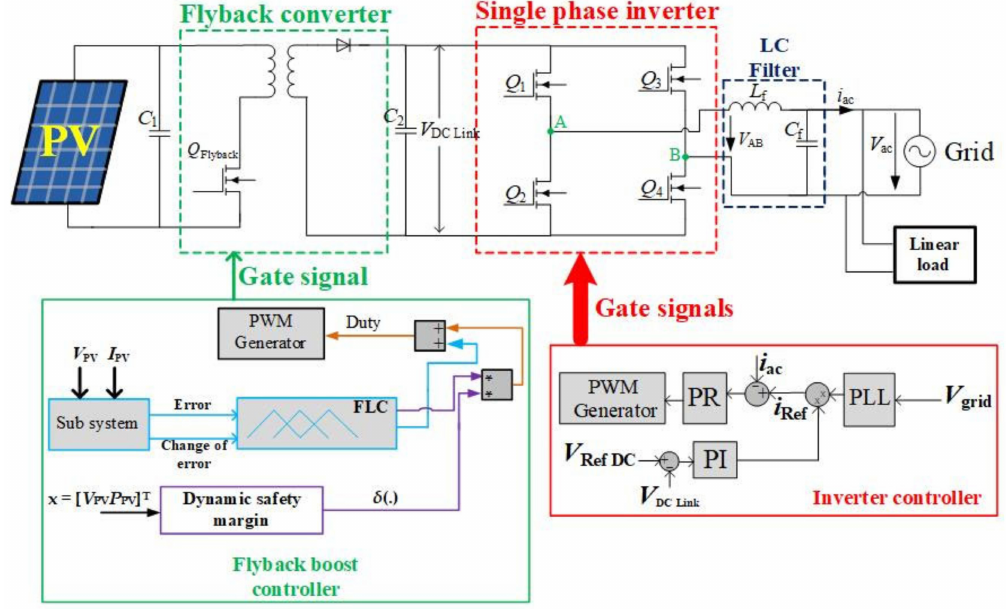
Figure 9. FLC using DSM for the PV system case